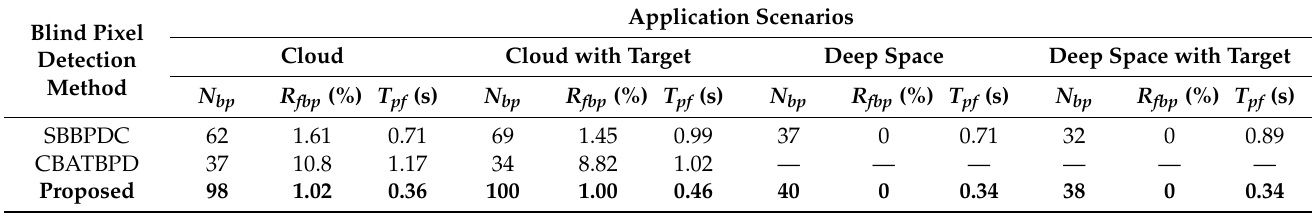
Table 3. The situation of blind pixels detected in four application scenarios.